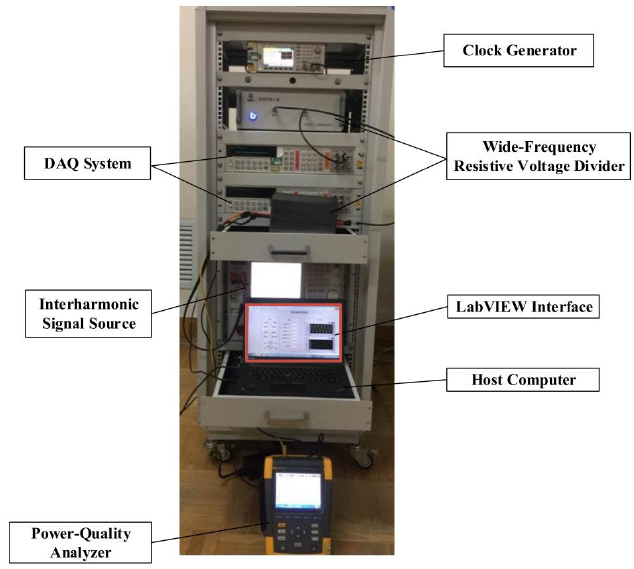
Figure 5. Hardware implementation for the interharmonic calibration scheme.